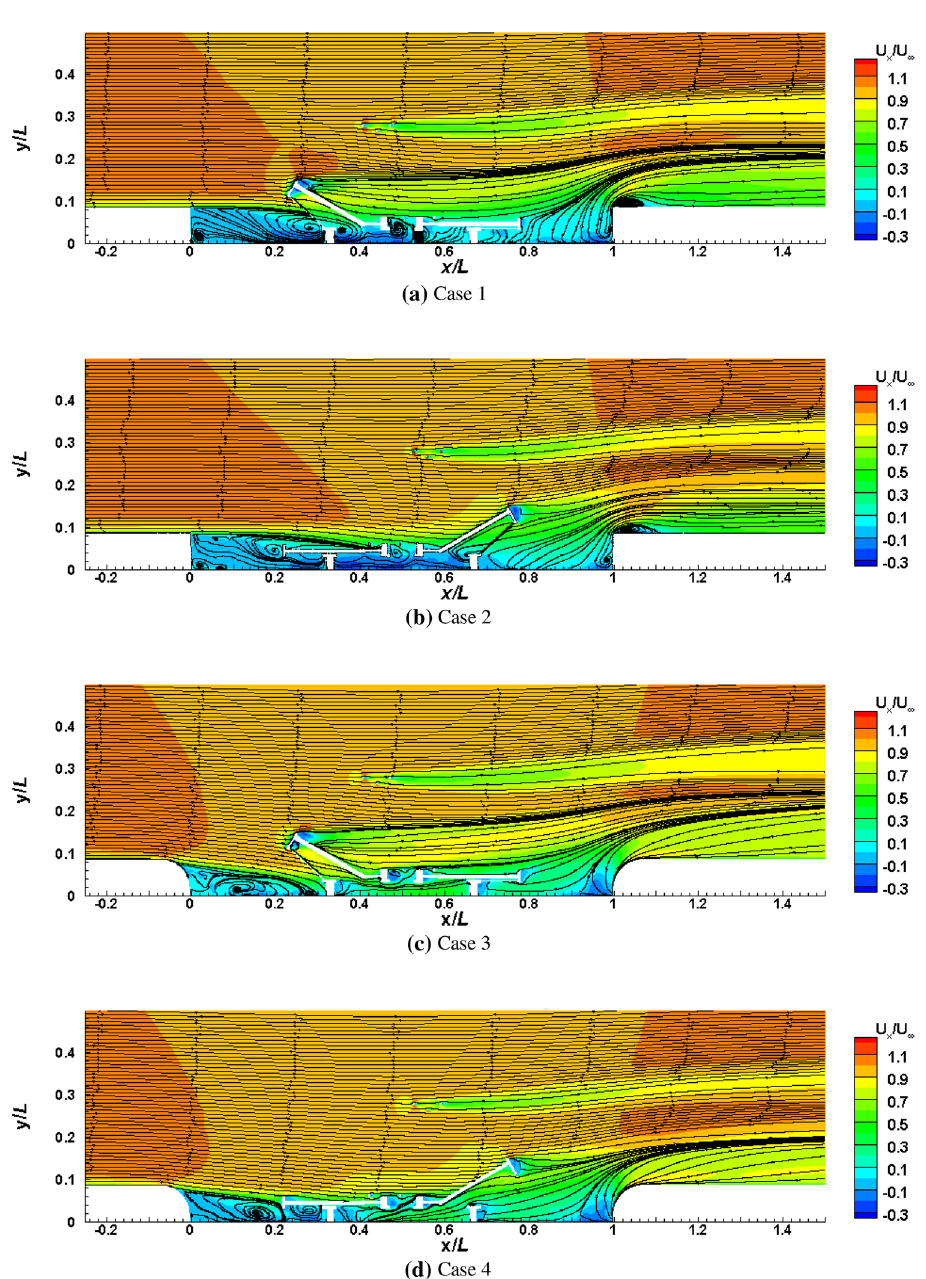
Fig. 12 Mean streamline with time-averaged velocity